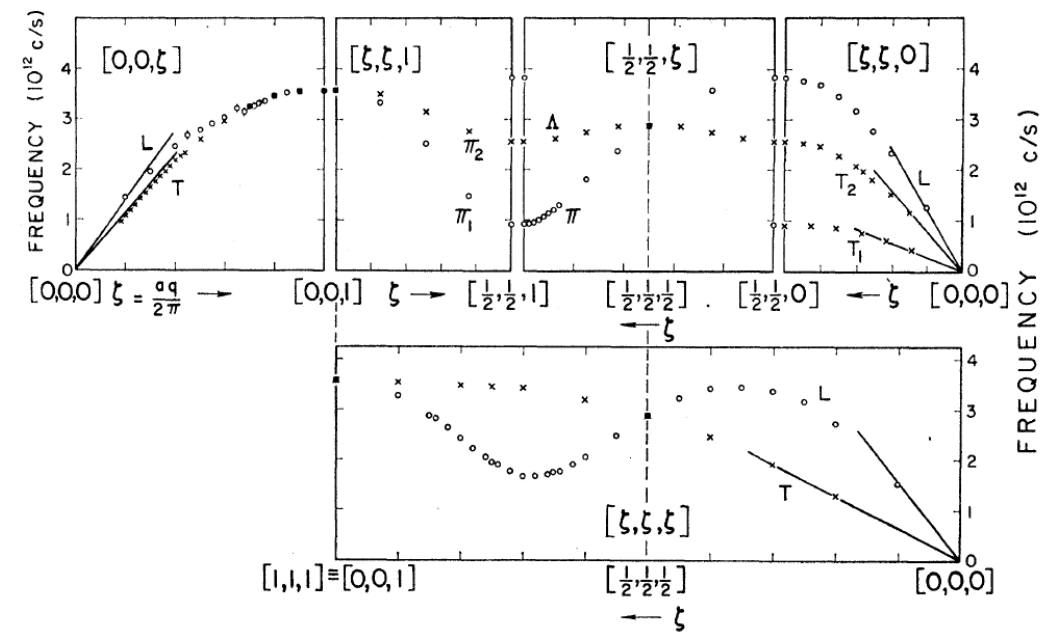
Figure 22. The phonon dispersion relation in body-centered cubic sodium at 90K. The solid lines from q = 0 have been calculated from the best available values of the elastic constants at 90K. The abscissa for the [ ζζζ ] direction has been stretched to emphasize the equivalence of the points [½½½] and [111] with the corresponding points for [½½ ζ ] and [00 ζ ] shown above. This figure is taken from Figure 2 of ref. [63]. Copyright by the American Physical Society.